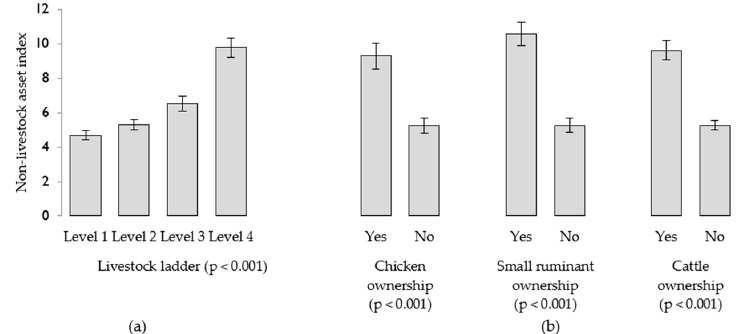
Figure 3. Model-based mean non-livestock asset index scores according to: ( a ) levels on the livestock ladder, and ( b ) ownership of chickens, sheep or goats, and cattle. Standard errors are shown.